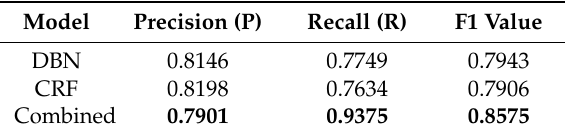
Table 6. Performances of geographical entity recognition of DBN and CRF models.